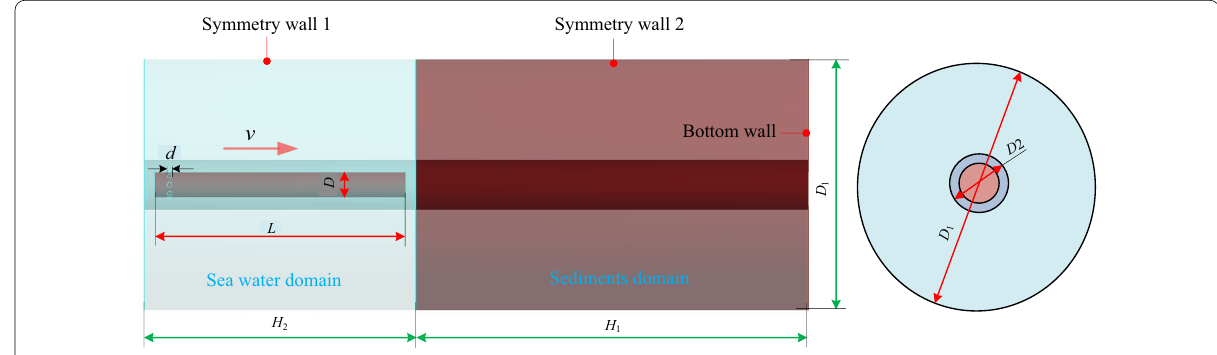
Figure 2 Computational fluid dynamics model of